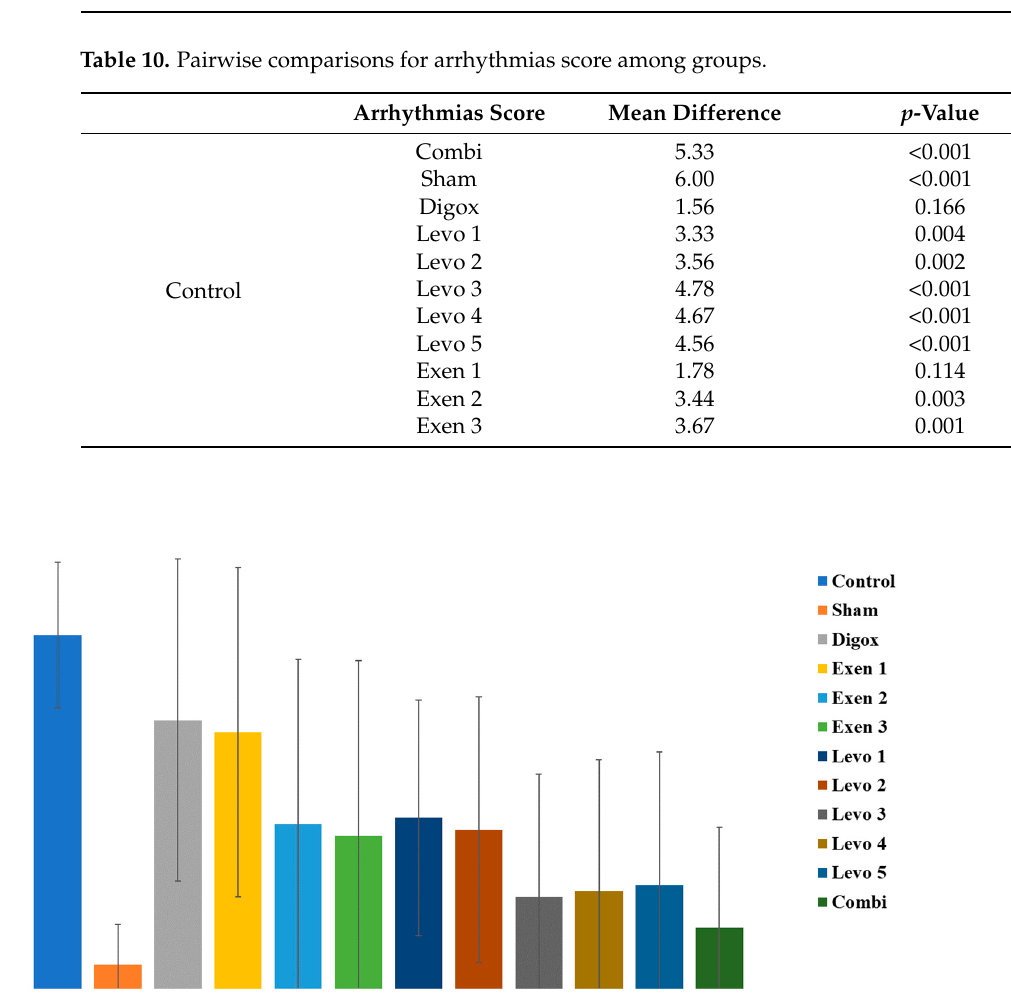
Figure 11. Differences in arrhythmias score across groups.